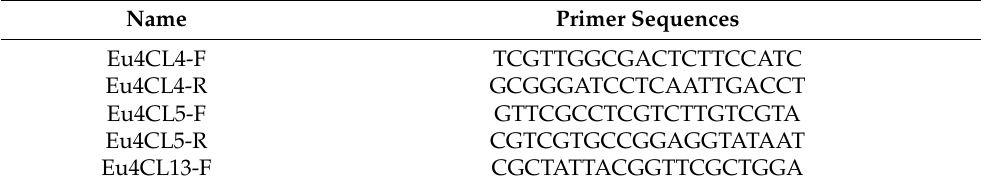
Table 1. The primers used in qRT-PCR